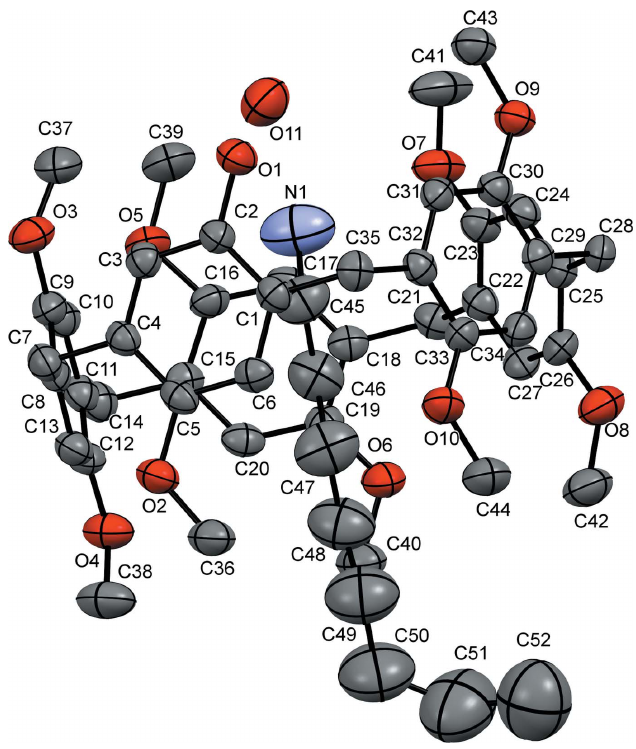
Figure 1 Displacement ellipsoid representation (30% probability) of Pil- OH (cid:2) OctNH 2 . Hydrogen atoms are omitted for clarity.